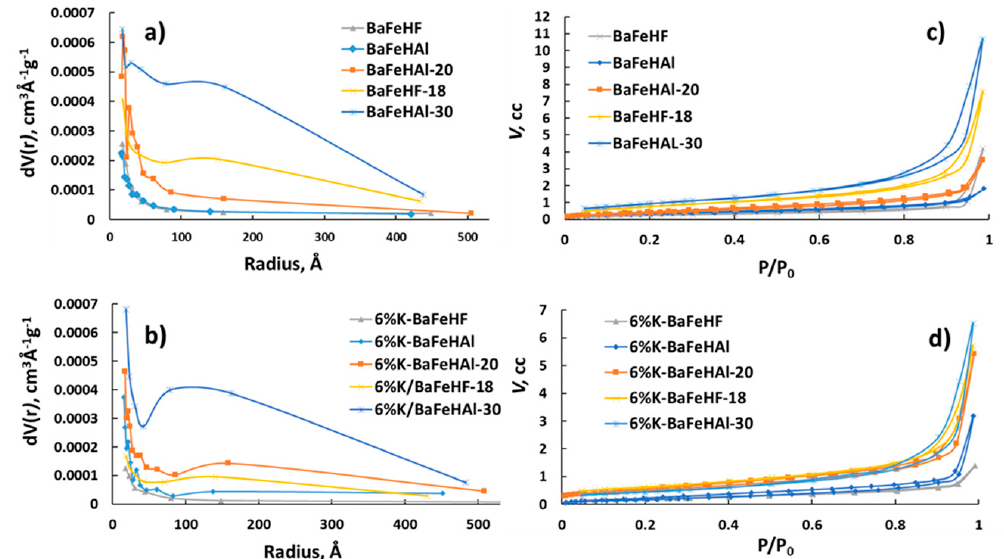
Figure 2. Pore size distributions ( a , b ) and N 2 adsorption-desorption isotherms ( c , d ) of BaFeHAl, BaFeHF, BaFeHAl-20, BaFeHAl-30, and BaFeHF-18 catalysts—as-prepared and doped with 6 wt% potassium.